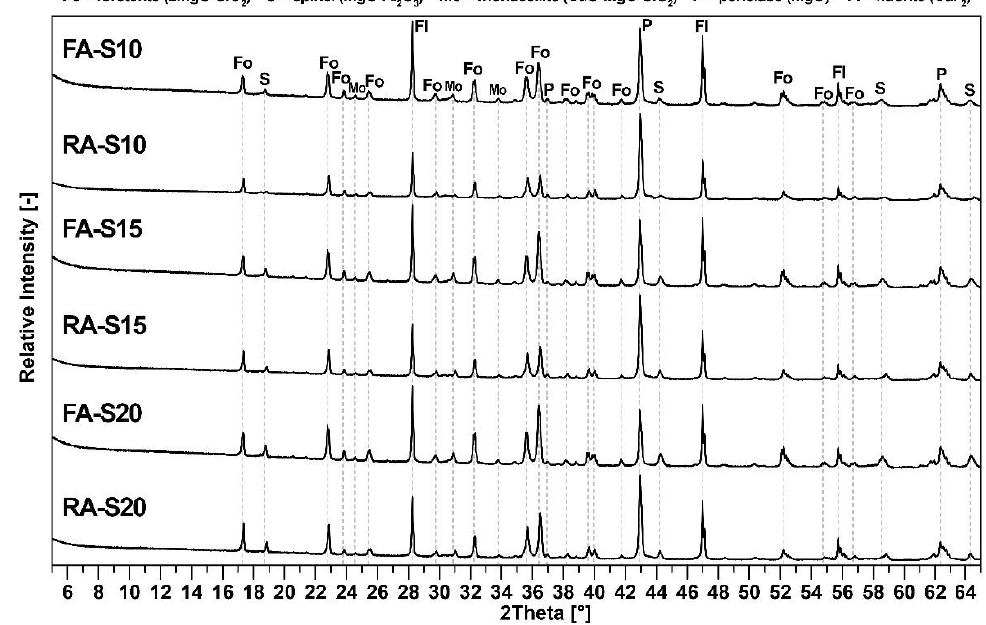
Figure 3. X-ray diffraction analysis of all fly ash – based and reactive alumina – based mixtures. Table 3. Quantitative phase composition of all mixtures.